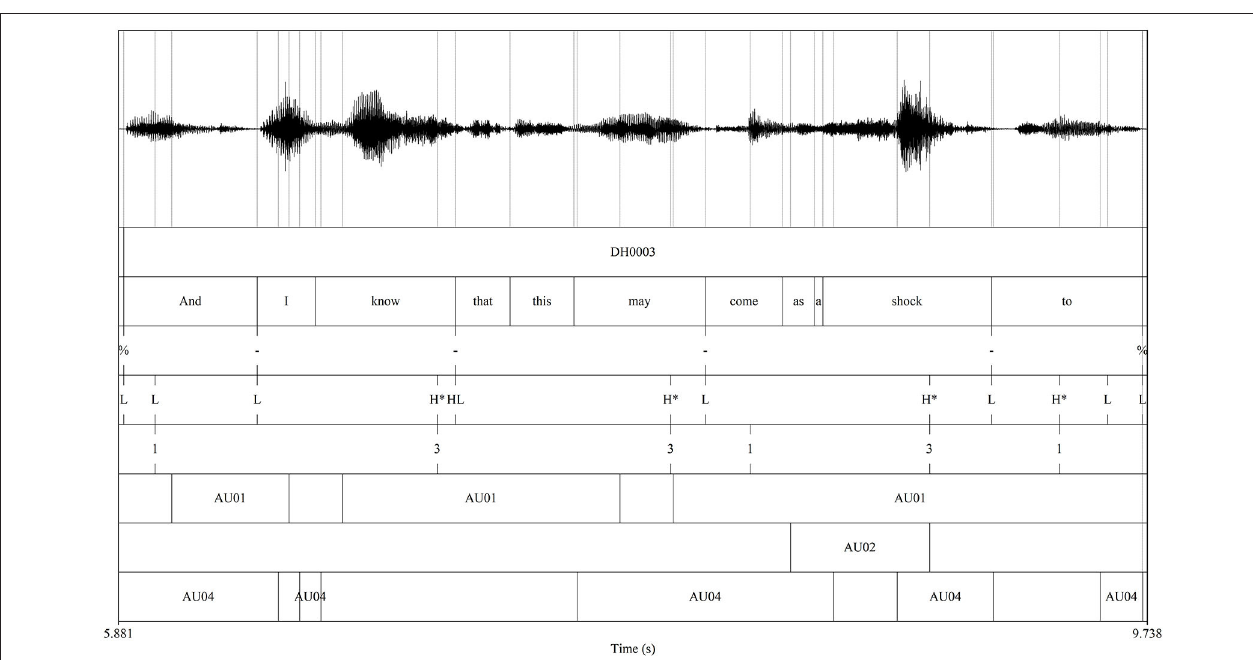
FIGURE 3 | An example annotation with DIMA and the AUs added by a script. Boundaries for the AU intervals were placed at the first and last points an AU occurred. For ease of readability, the AU05 tier is removed here as it was not present in the selection.